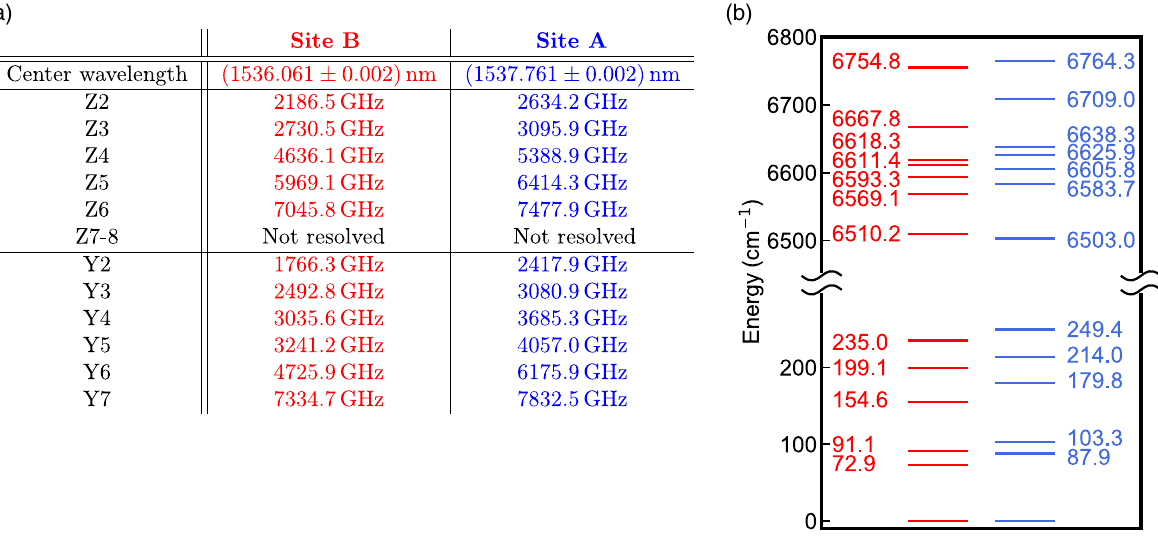
FIG. 8. Energy of the crystal-field levels of sites A (blue) and B (red). (a) Frequency difference of the CF levels with respect to the ground state of the respective manifold. (b) Level scheme with the corresponding wavenumbers. The excited state includes all CF levels of the 4 I 13 = 2 state manifold, whereas in the 4 I 15 = 2 ground-state manifold, two levels have not been detected because the filter used only tunes to 1600 nm.